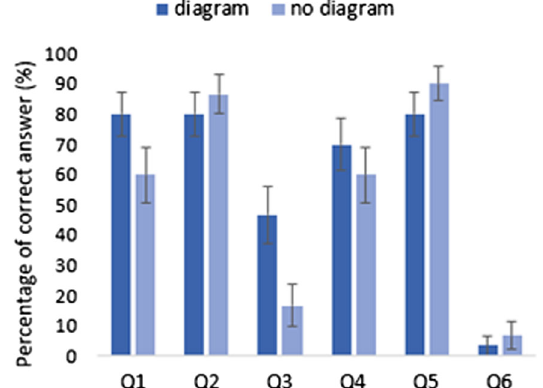
FIG. 1. Comparison of students ’ percentages of correct answers on all questions (Q1 – Q6) between the two conditions (diagram, no diagram). The error bars represent 1 SEM.